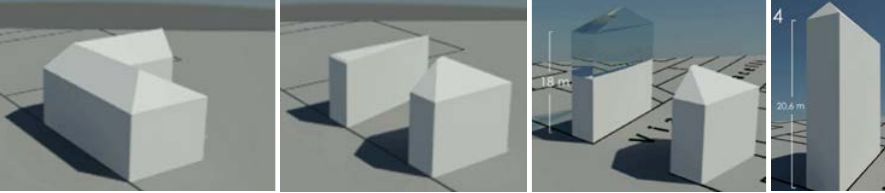
Figure 5. The “Fetta di polenta” evolution at urban scale